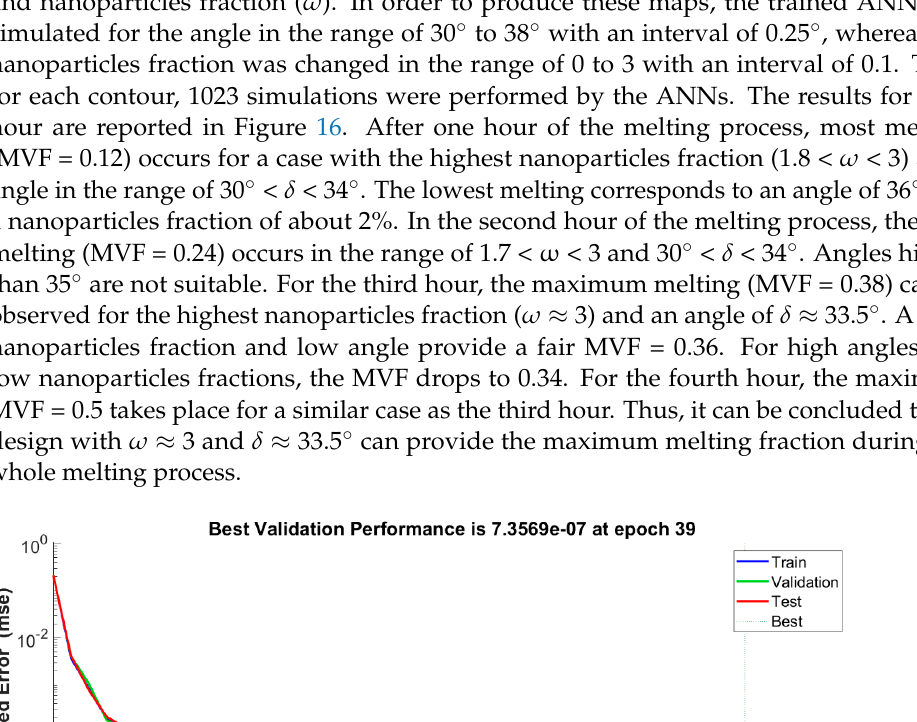
Figure 13. The performance curves during the training process. Epoch 39 provided the best validation performance and was selected for simulations.